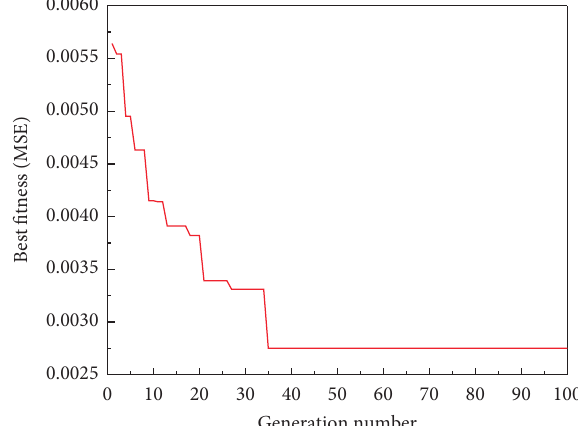
Figure 3: Testing results of GA optimization in terms of best fitness